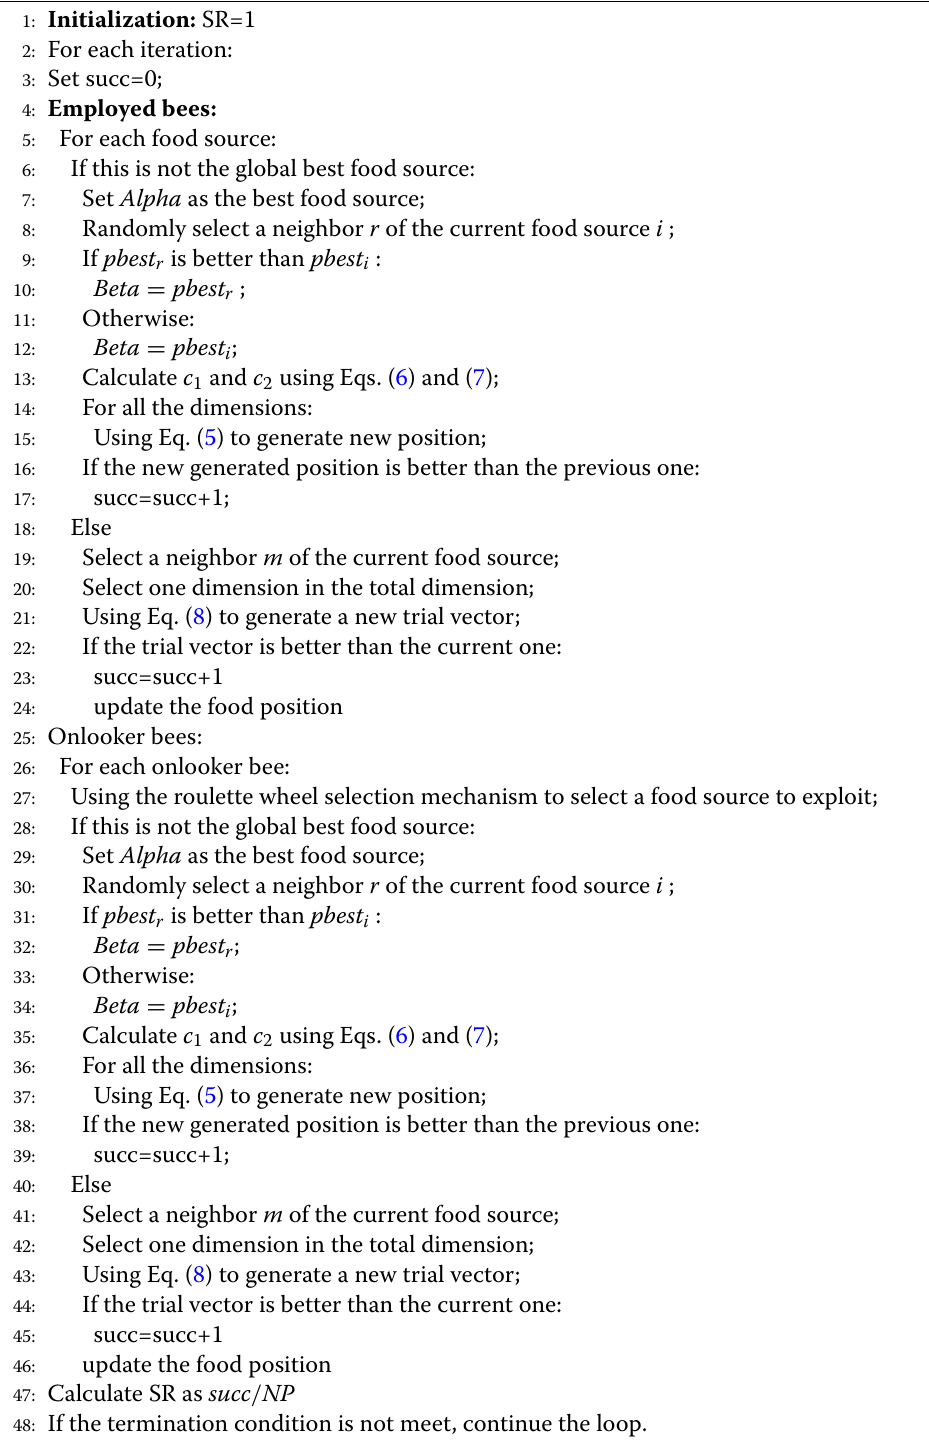
Algorithm 1: The main pseudo code of ABCIS